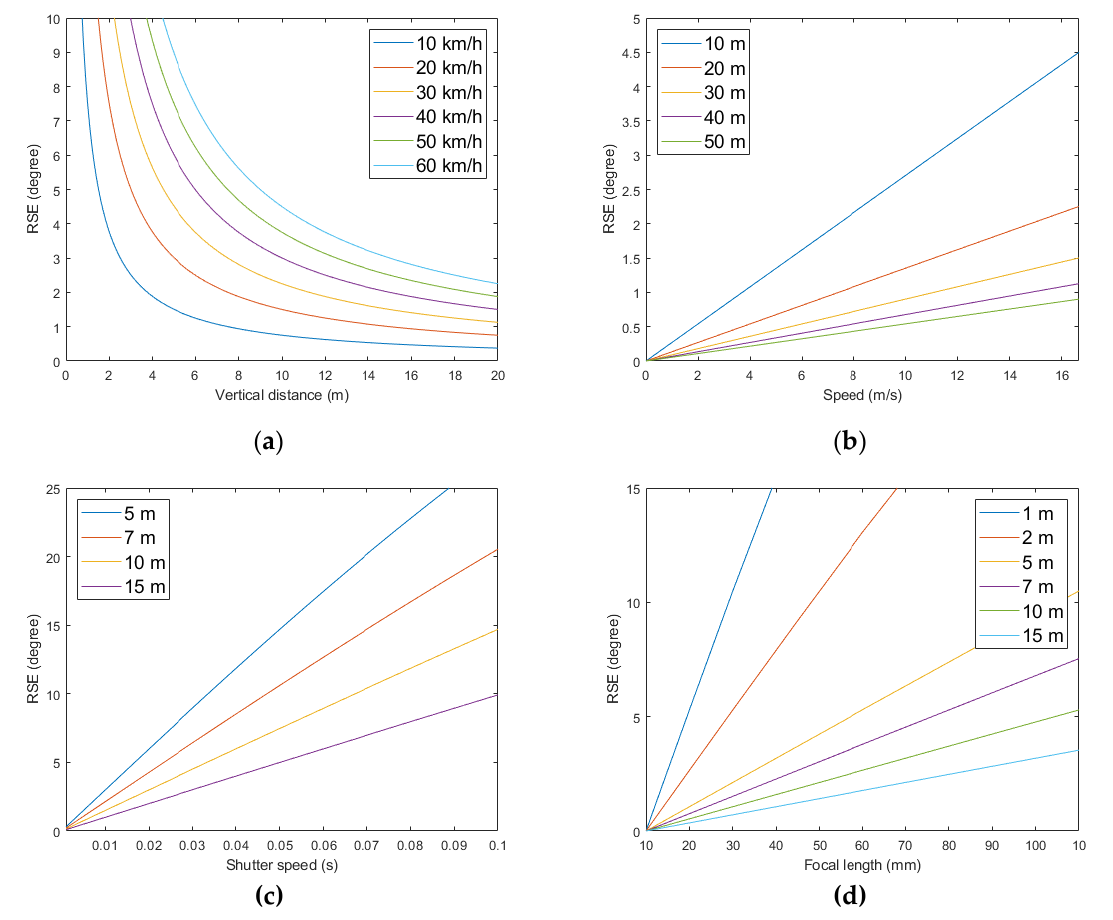
Figure 12. The RSE occurrence graph with respect to the parameters: (a) vertical distance-RSE; (b) speed-RSE; (c) shutter speed-RSE; and (d) focal length-RSE.